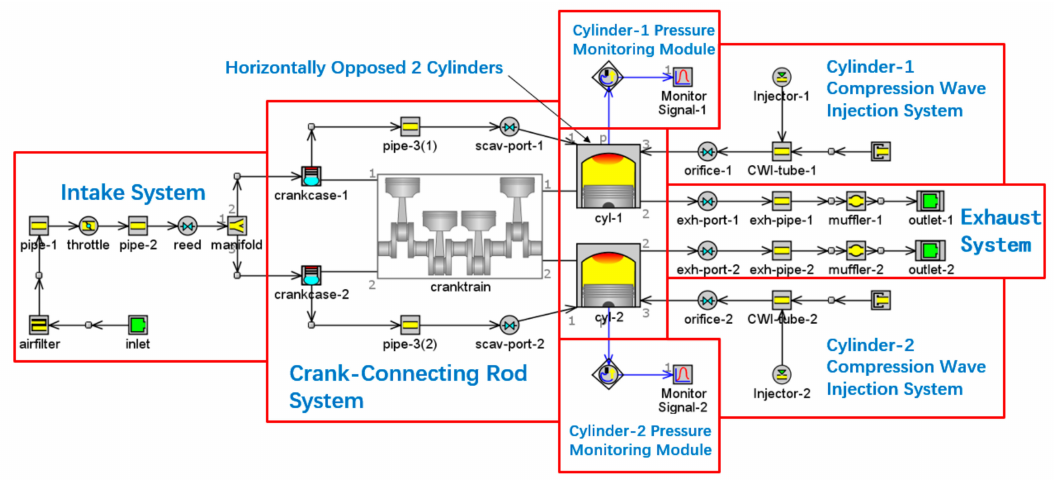
Figure 25. The layout of integrated simulation platform in GT-ISE (reference